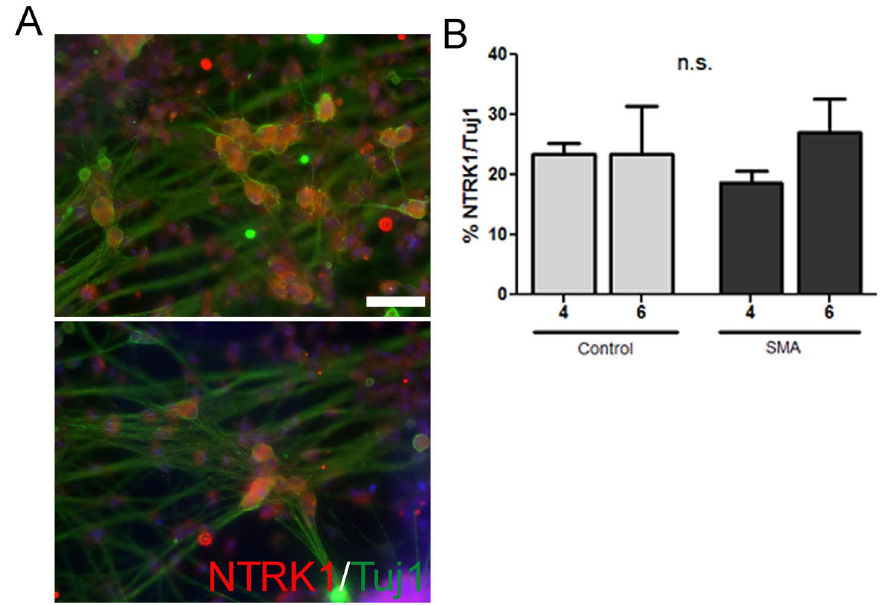
Figure 2. Generation of nociceptive neurons from control and SMA iPSCs. (A) Control and SMA iPSCs generate nociceptive neurons as indicated by NTRK1 (red) and Tuj1 (green). Nuclei are labeled with Hoechst nuclear dye (blue). (B) There was no difference in neuron differentiation between control and SMA iPSC cultures at either 4 or 6 weeks of differentiation. n.s.=not significant by ANOVA. Scale bar=50 m m.